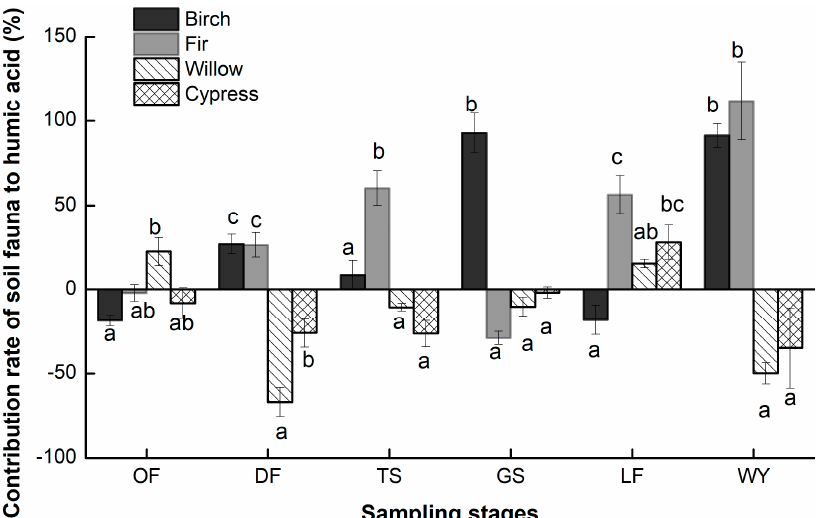
Figure 5. The contribution rate of soil fauna to the accumulation of four litter humic acid in different stages (mean ± standard error, n = 3). OF: onset of freezing stage, DF: deep freezing stage, TS: thawing stage, GS: growing season, LF: leaf falling stage, WY: whole year. The letters a–c mean in the sampling stage with different letters differ significantly, P < 0.05.